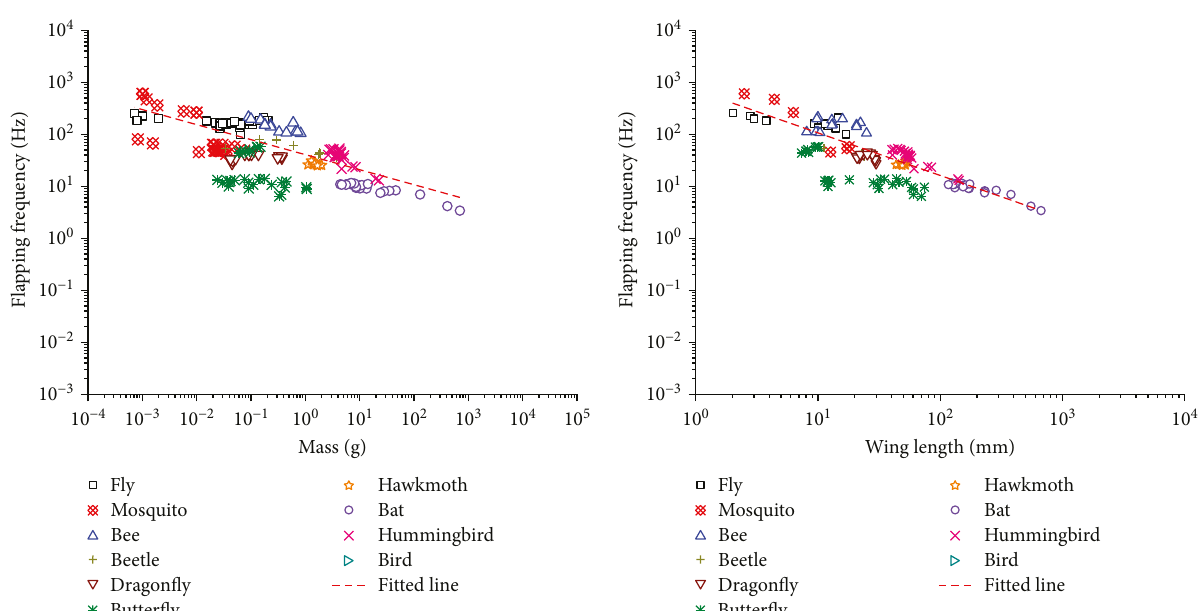
Figure 3: The relation of fl apping frequency vs. mass (left), and fl apping frequency vs. wing length